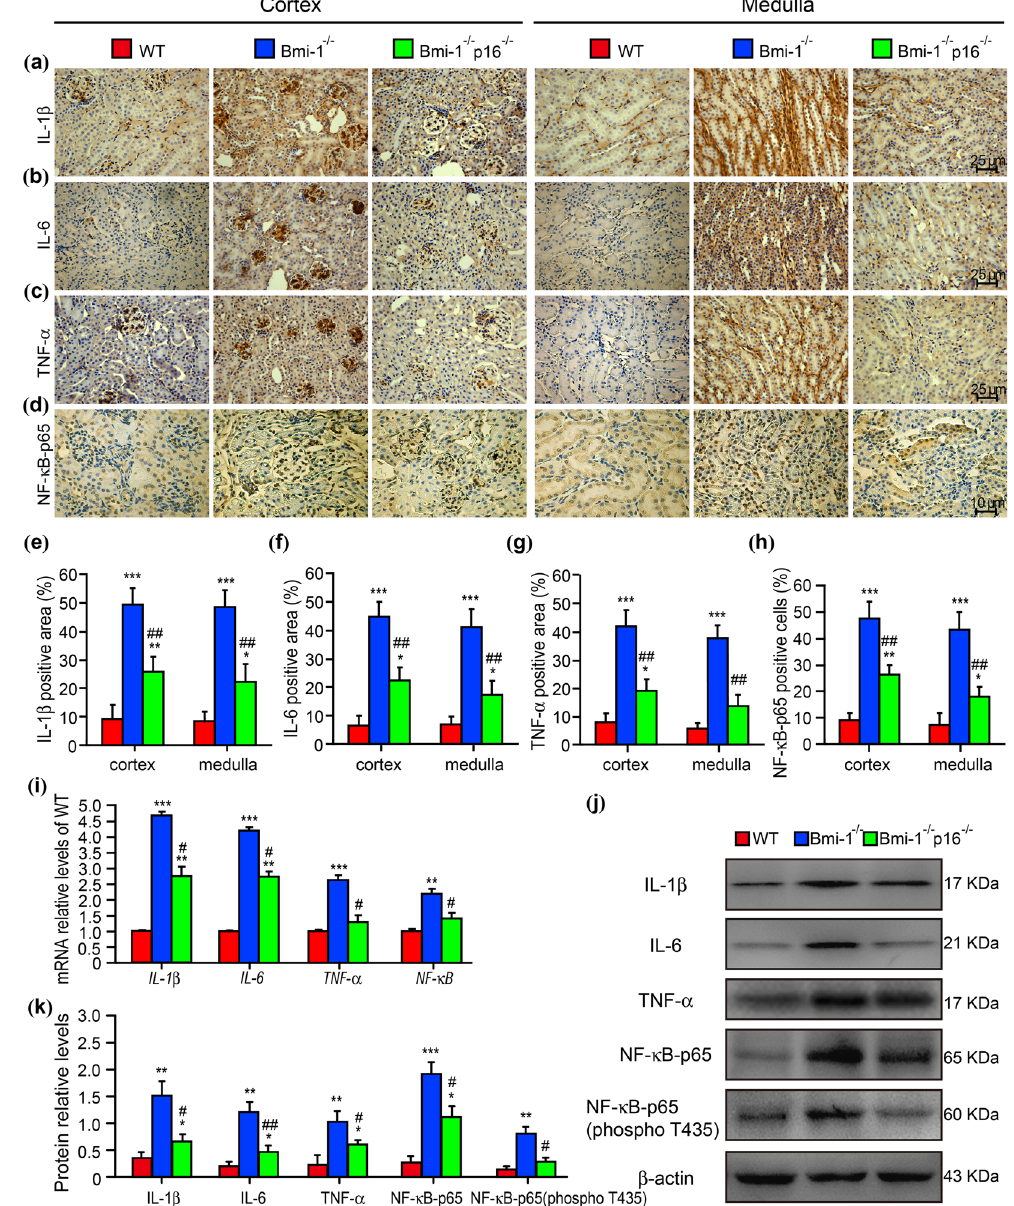
Figure 3. P16 deletion improved senescence-associated pro-inflammatory secretory phenotype in Bmi - 1 − / − mice. Representative micrographs of paraffin-embedded kidney sections stained immunohistochemically for ( a ) IL-1 β , ( b ) IL-6, ( c ) TNF- α and ( d ) NF- κ B-p65. Percentage of ( e ) IL-1 β positive area, ( f ) IL-6 positive area, ( g ) TNF- α positive area or ( h ) NF- κ B-p65 positive cells relative to total cells or area. ( i ) IL - 1 β , IL - 6 , TNF - α and NF - κ B mRNA levels in kidneys by real-time RT-PCR, calculated as ratio to GAPDH mRNA and expressed relative to WT. ( j ) Western blots of kidney extracts showing IL-1 β , IL-6, TNF- α , NF- κ B-p65 and NF- κ B-p65 (phospho T435). β -actin was the loading control. ( k ) Protein levels relative to β -actin were assessed by densitometric analysis. Six mice per group were used for these experiments. Values are mean ± SEM from six determinations per group. * P < 0.05, ** P < 0.01, *** P < 0.001 compared with WT group; # P < 0.05, ## P < 0.01 compared with Bmi - 1 − / −